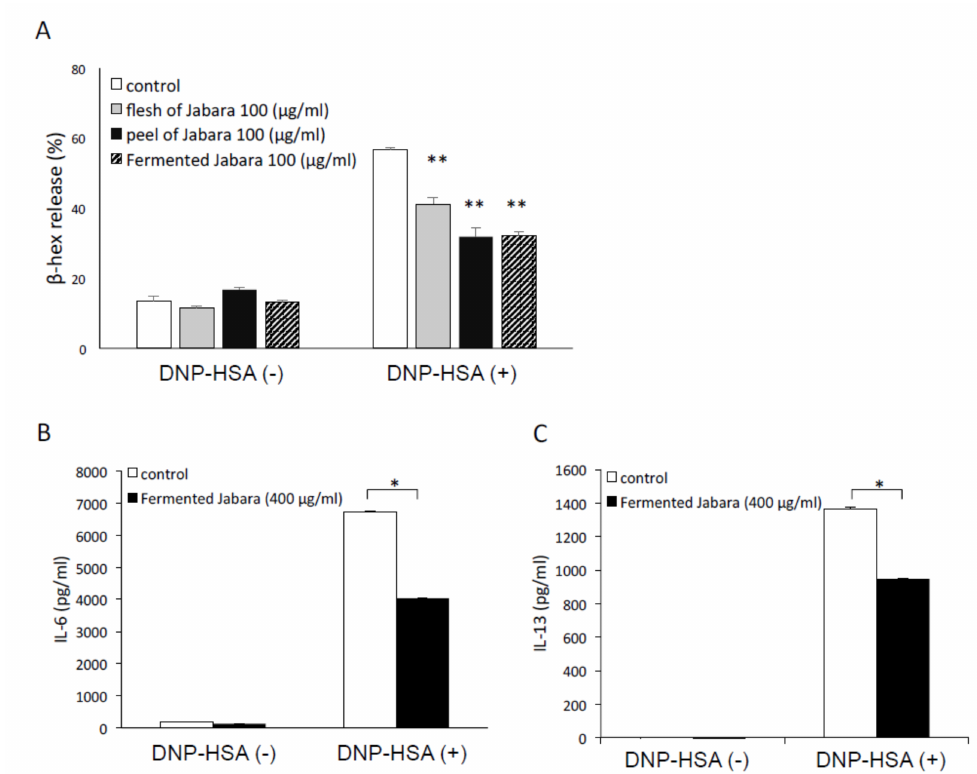
Figure 1. ( A ) Inhibitory e ff ect of DMSO extract of flesh and peel of raw Jabara, as well as the extract of fermented Jabara (four weeks) on β -hexosaminidase ( β -hex) release from mast cells. IgE-sensitized mast cells (1.0 × 10 5 cells / well) were preincubated with each extract at 37 ◦ C for 15 min prior to 30 min stimulation with DNP-HSA. Data represent one of at least three trials that showed similar results. Data are presented as mean (SD). ** p < 0.01, two-tailed Student’s t -test. ( B , C ) Inhibitory e ff ect of DMSO extract of fermented Jabara on cytokine production in mast cells. Mast cells were stimulated with 10 ng / mL DNP-HSA for 6 h with or without the addition of fermented Jabara. IL-6 (B) and IL-13 (C) production were measured by ELISA. Data represent one of at least three trials that showed similar results. Data are presented as mean (SD). * p < 0.05, two-tailed Student’s t -test.